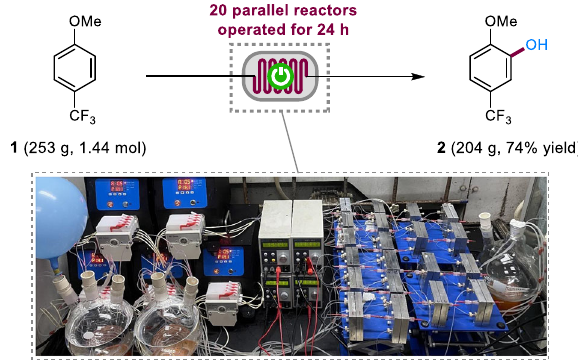
Fig. 4 Reaction scale-up employing 20 parallel reactors. Reaction conditions: graphite anode, Pt cathode, MeCN, constant current = 200 mA (for each reactor), 0.5 mL min − 1 (for each reactor), 1 (0.1 M), 2.5 F mol − 1 , rt, 24